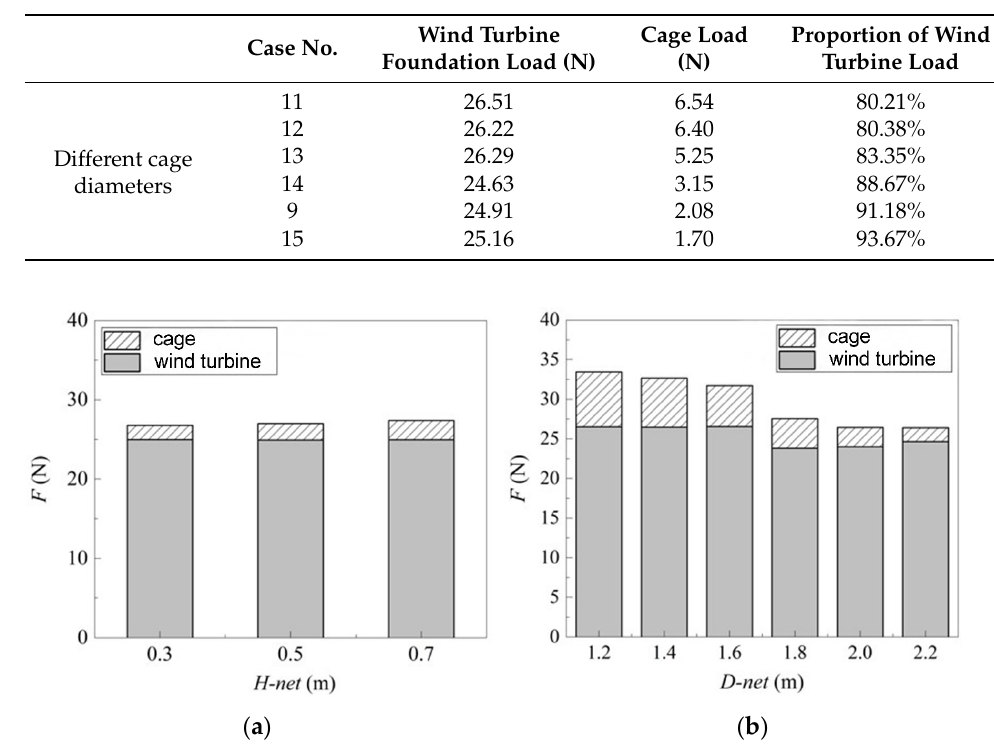
Figure 11. Hydrodynamic load distribution of the combined structure under different cage heights ( a )